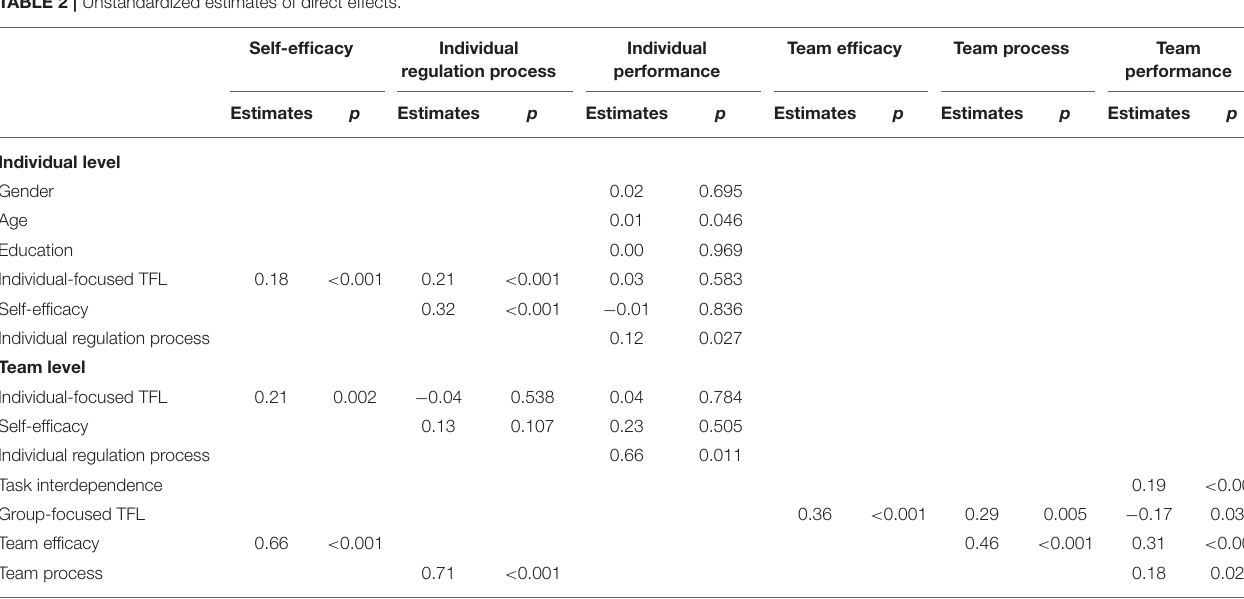
TABLE 2 | Unstandardized estimates of direct